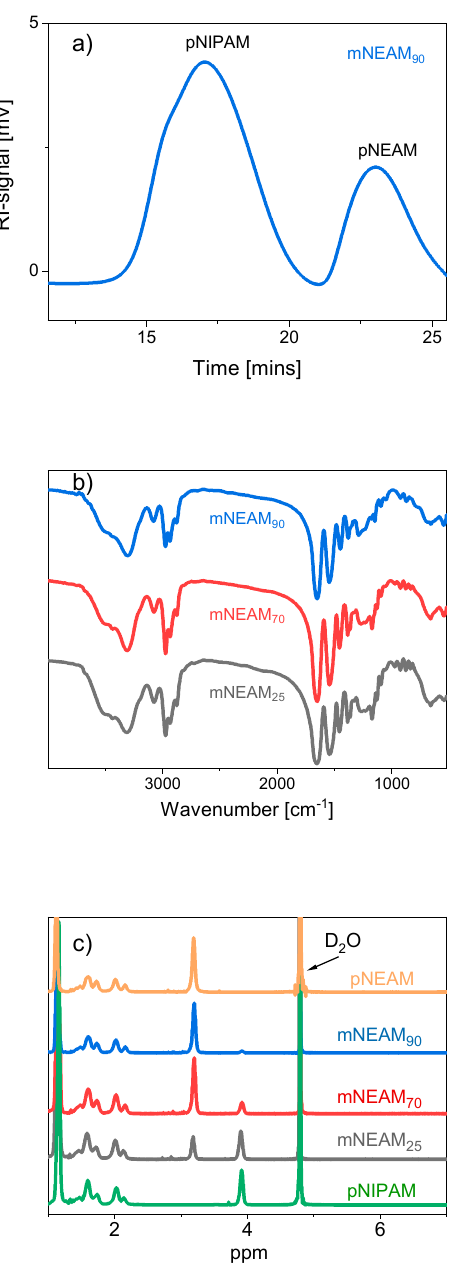
Figure 1. Molecular characterization of polymers and blends obtained by GPC ( a ), FTIR-spectra ( b ), and 1 H-NMR ( c ).